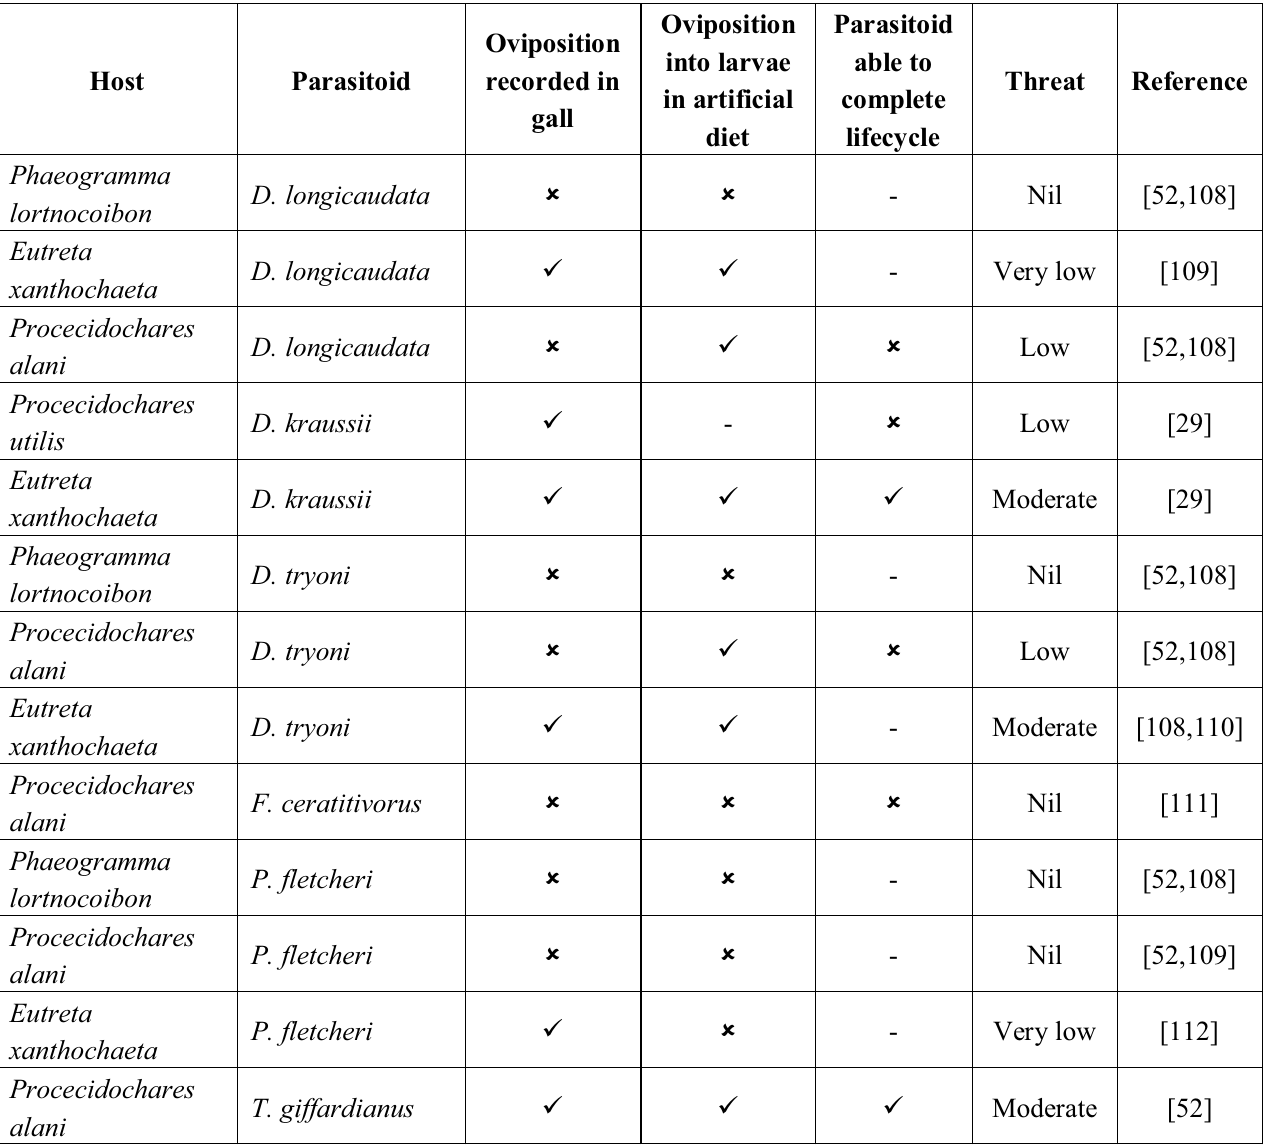
Table 2. Non-target impacts of opiine braconids, Diachasmimorpha , Fopius , Psyttalia , and Tetrastichus spp., on gall-forming tephritids. (- indicates no record). Host Parasitoid